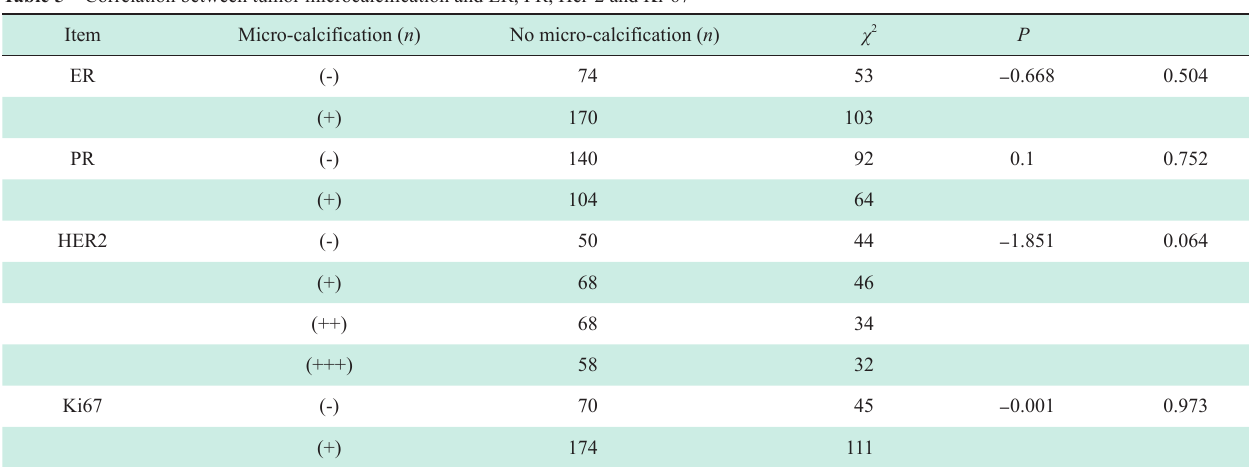
Table 5 Correlation between tumor microcalcification and ER, PR, Her-2 and Ki-67